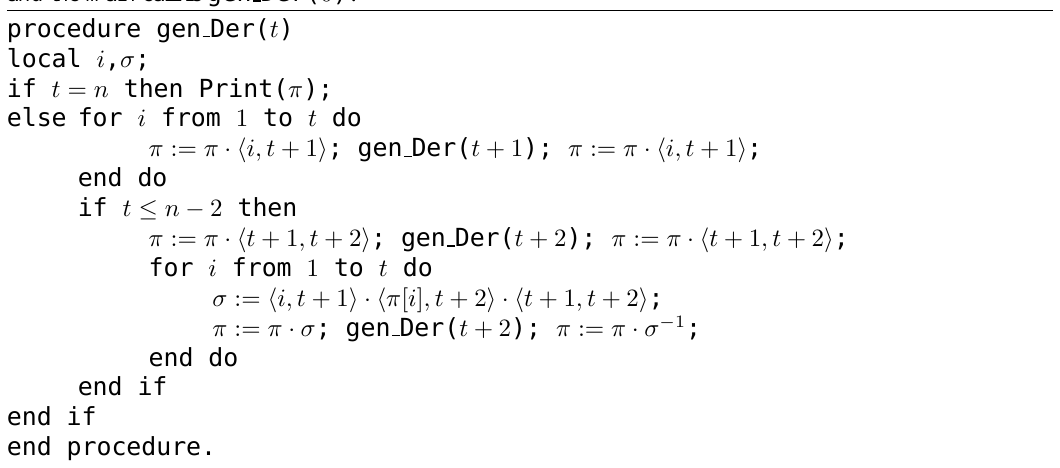
Algorithm 6 Procedure generating the set of all length- n derangements. π is initialized by 1 2 3 . . . n , and the main call is gen Der( 0 )